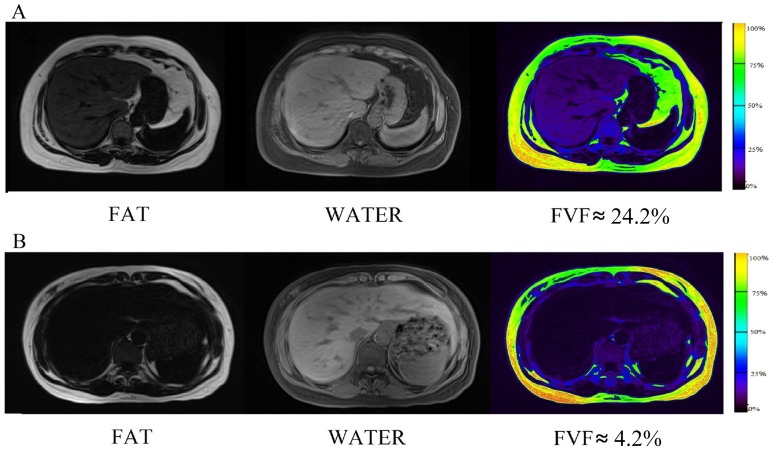
FVF maps of two typical subjects from IGT group (A) and NGTLean group (B).A: a 58 years old female who was diagnosed as IGT (BMI = 31.85), with a mean FVF of 24.23%. The fat phase and FVF map demonstrated that the deposition of fat is homogeneous. B: a 50 years old female (BMI = 23.13) with a mean FVF of 4.15%. The color of the liver in case B is much darker than that in case A, indicating a lower fat content.